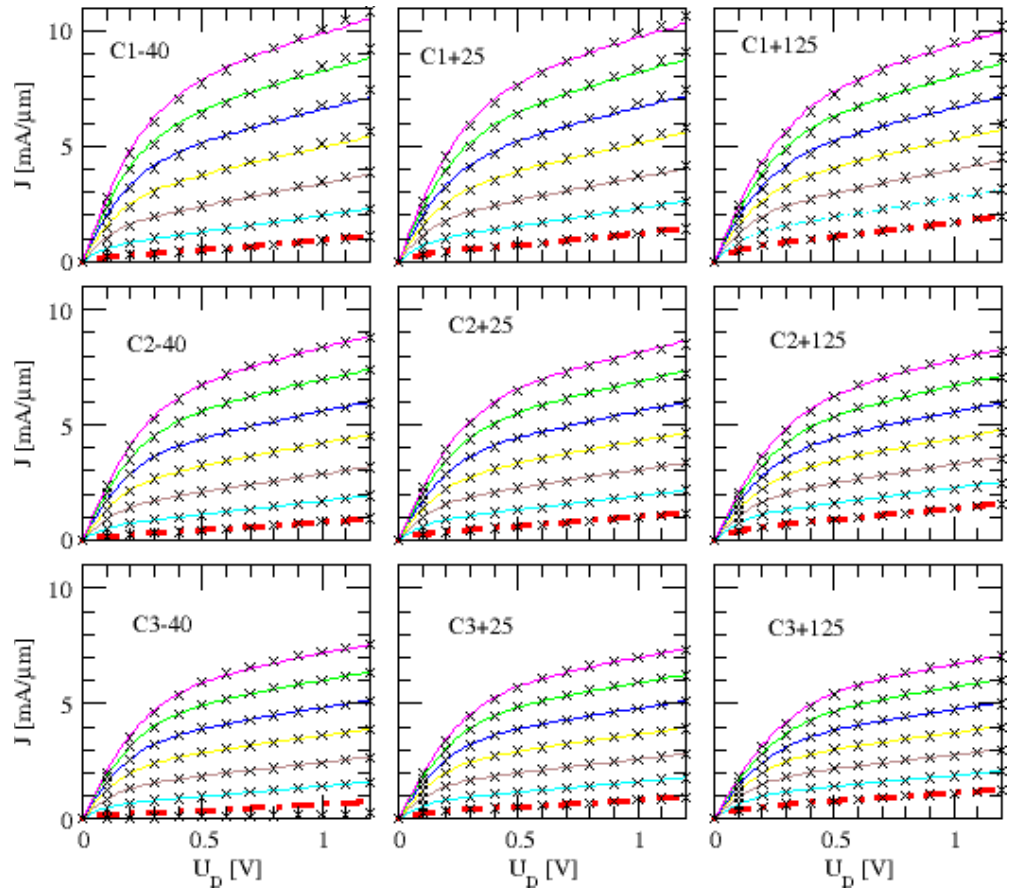
Figure 2. Experimental output traces J exp for the C-transistors in the ON-state regime: upper row C1, middle row C2 and lower row C3; left column environment temperature T = 233 K, middle column T = 298 K and right column T = 398 K; U G = 1.2 V (magenta solid lines), 1.1 V (green), = 0.6 V (red, close to linear threshold 1 V (blue), 0.9 V (yellow), 0.8 V (brown), 0.7 V (cyan) and U th G trace). Theoretical results J cal according to (10) in black